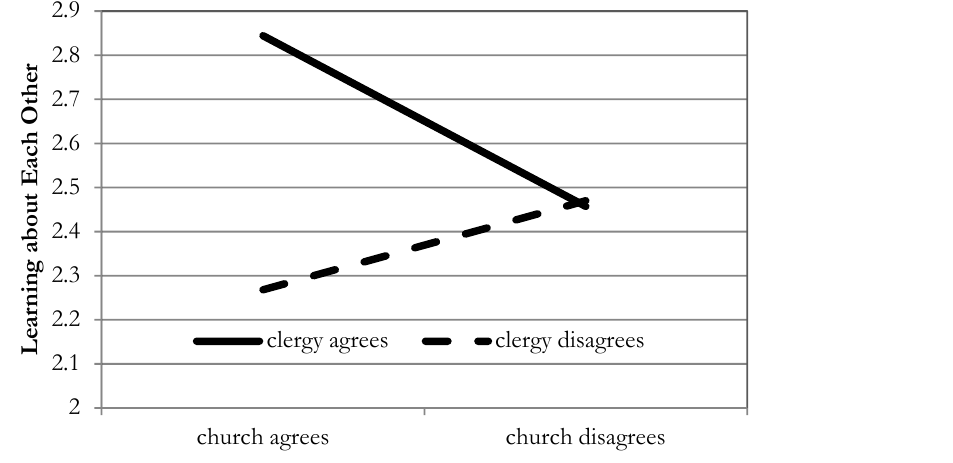
Figure 7 : Interactive Effect of Clergy and Congregational Stance on the Vote on Whether Participants Learned about Their Differences and Each